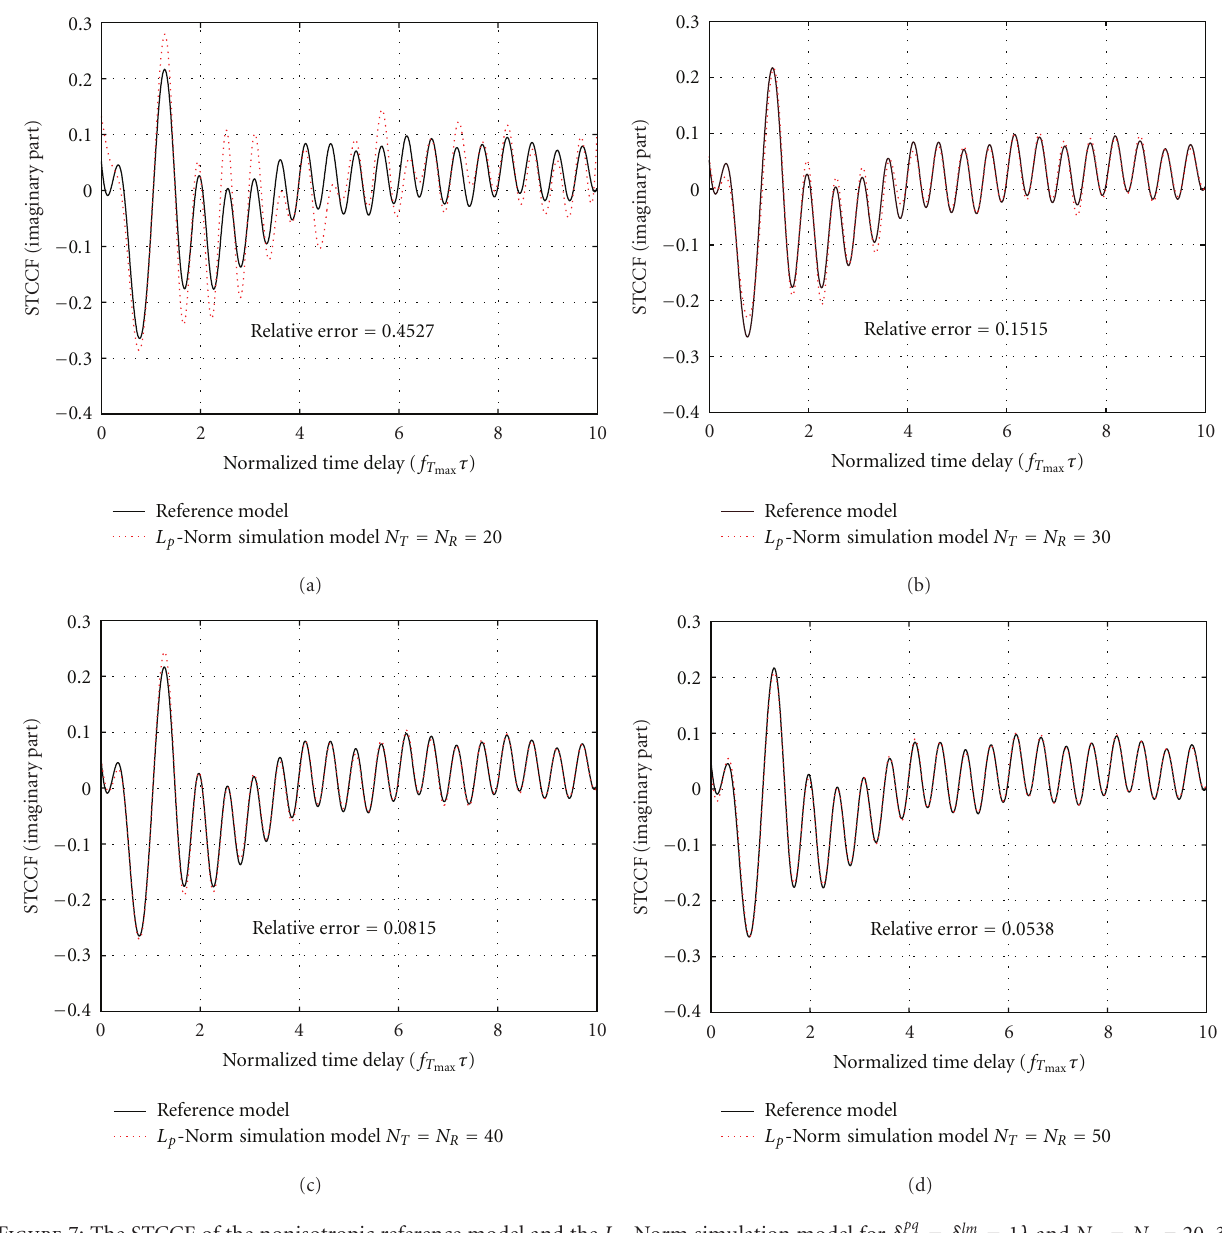
Figure 7: The STCCF of the nonisotropic reference model and the L p -Norm simulation model for δ 40, 50 (imaginary